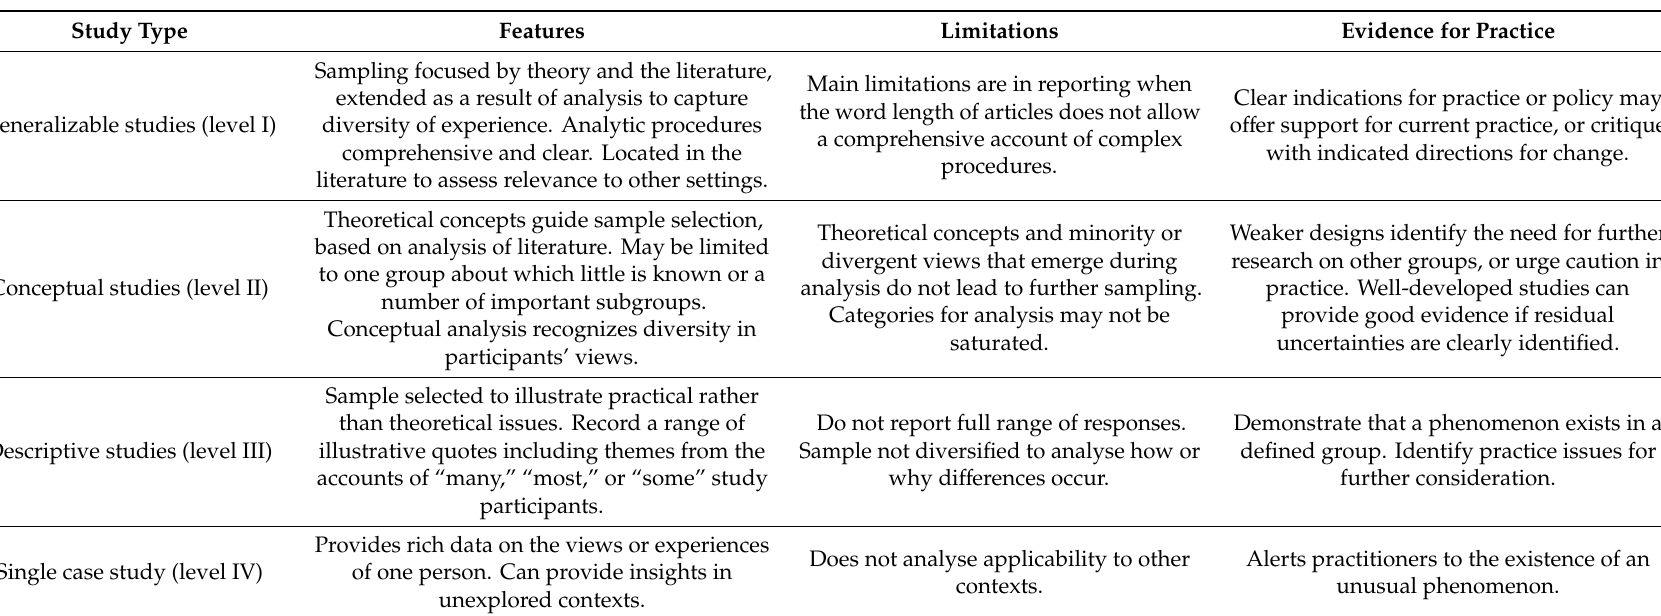
Table A1. A summary of the hierarchy of evidence-for-practice in qualitative research